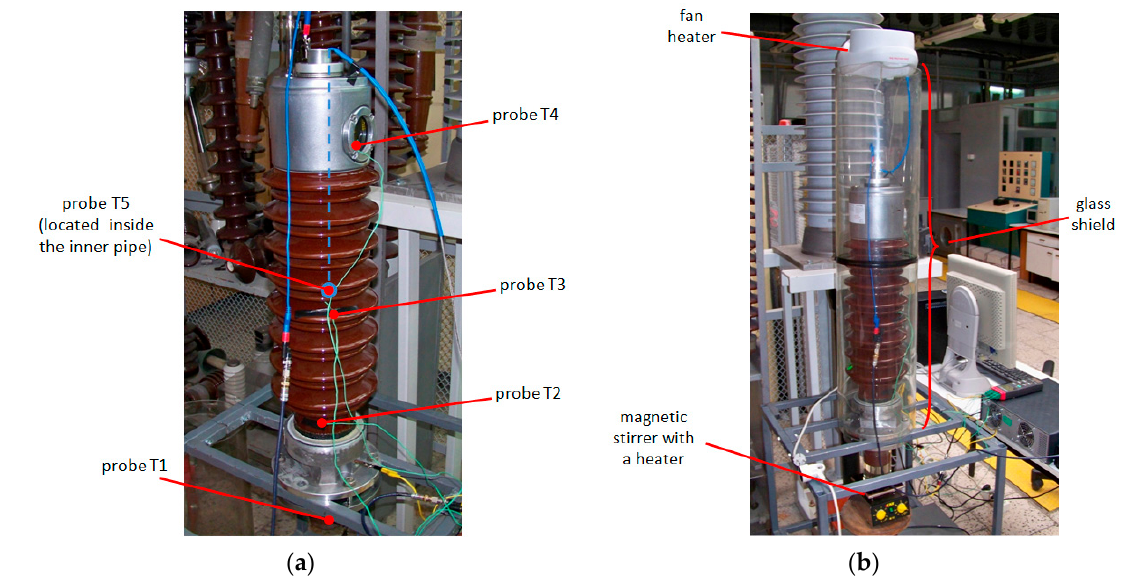
Figure 4. Arrangement of temperature sensors ( a ); insulator heating system ( b ).